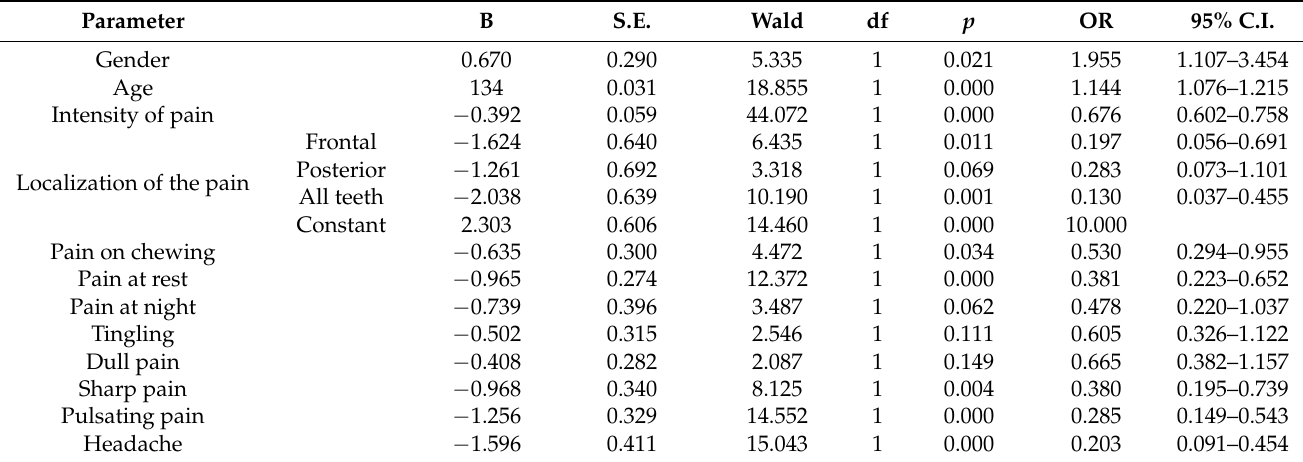
Table 2. Variables tested with univariable analysis whose p values were less than 0.25 and were therefore included in the further analysis.